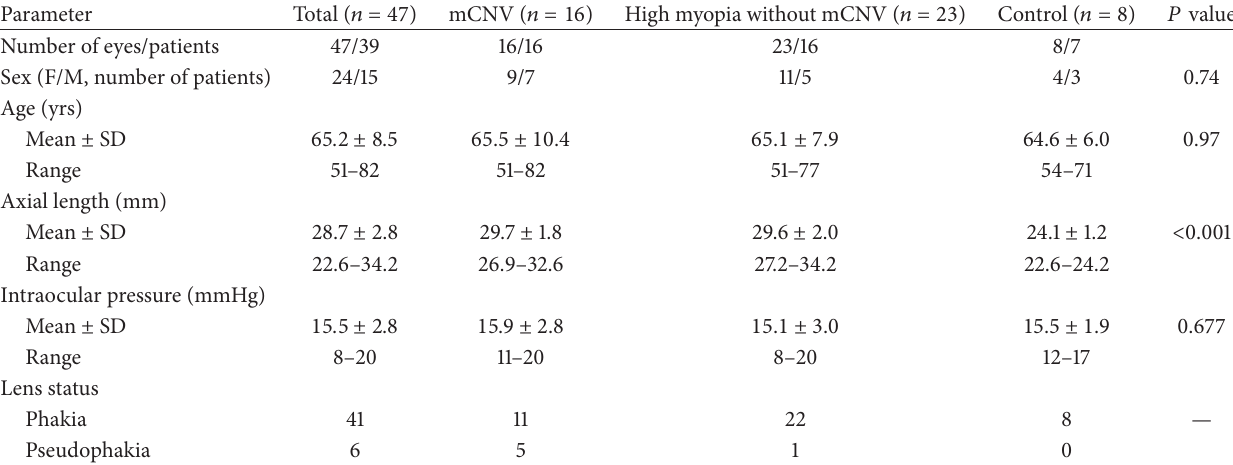
Table 1: Characteristics of eyes with myopic choroidal neovascularization, high myopia without myopic choroidal neovascularization, and control.